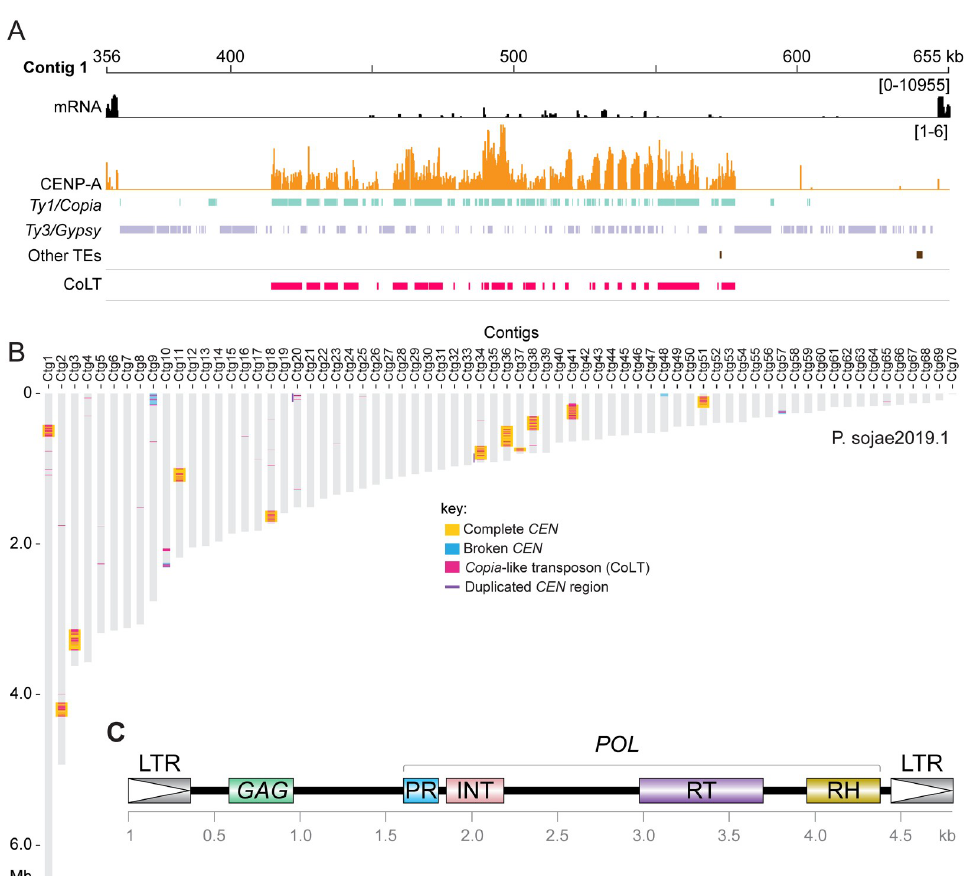
Fig 5. P . sojae centromeres are enriched for a Copia -like transposon (CoLT). (A) Distribution of transposable elements (TEs) in CEN1 . TEs were annotated using a Phytophthora TE library from Repbase [45]. Tracks of different repeat families are color coded. The track “Other TEs” includes all types of TEs beyond Gypsy and Copia . CoLT was composed of three elements annotated in Repbase [45], namely Copia-24_PIT-I, Copia-24_PIT-LTR and Gypsy- P17-PR-I. The profile of CENP-A shown was normalized to input. The mRNA track is shown as log-scales and used to define the boundary of pericentric heterochromatin. (B) Location of CoLT elements across all of the Psojae2019.1 contigs. (C) Diagram showing the domain structure of a representative full-length CoLT sequence (see S3 File). The coding domain featured as Copia superfamily of retrotransposons, which consists of capsid protein (GAG), Gag-pre- integrase (PR), integrase (INT), reverse transcriptase (RT), and RNase H (RH) domains, and diverges from the Gypsy superfamily in the order of the RT and INT domains in their POL genes [86].